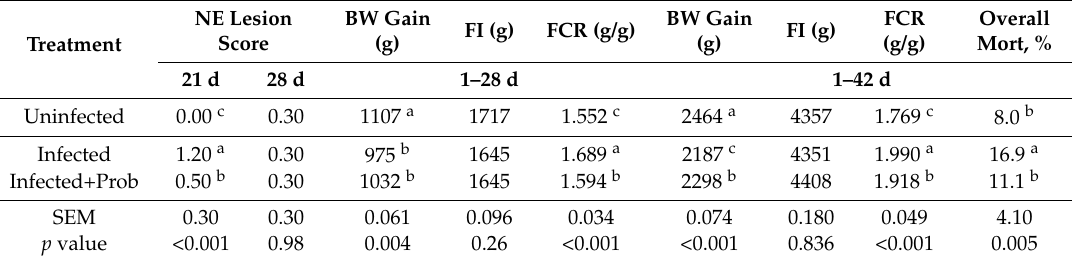
Table 2. Growth performance and intestinal necrotic enteritis (NE) lesion score of broilers challenged with an experimental model to reproduce NE and supplemented with Bacillus subtilis DSM